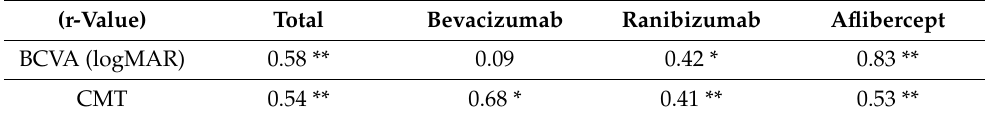
Table 2. Correlation between d7 value and dL value for BCVA and